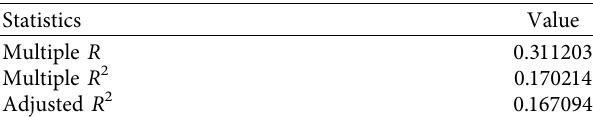
Table 2: Summary statistics (confirmed COVID-19